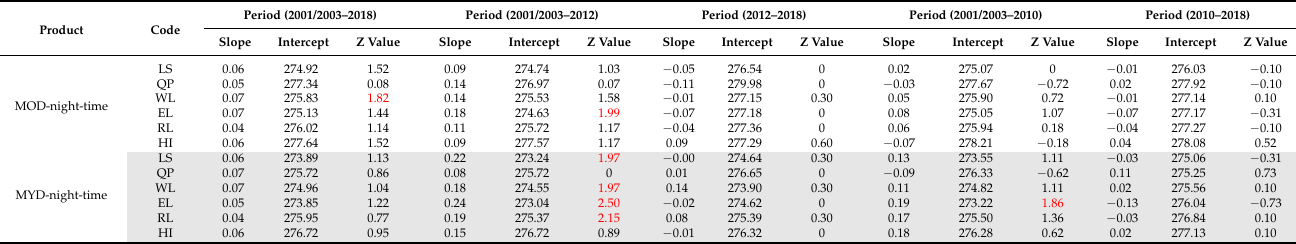
Table 3. Linear trends (K year − 1 ) of MODIS LSWT over six